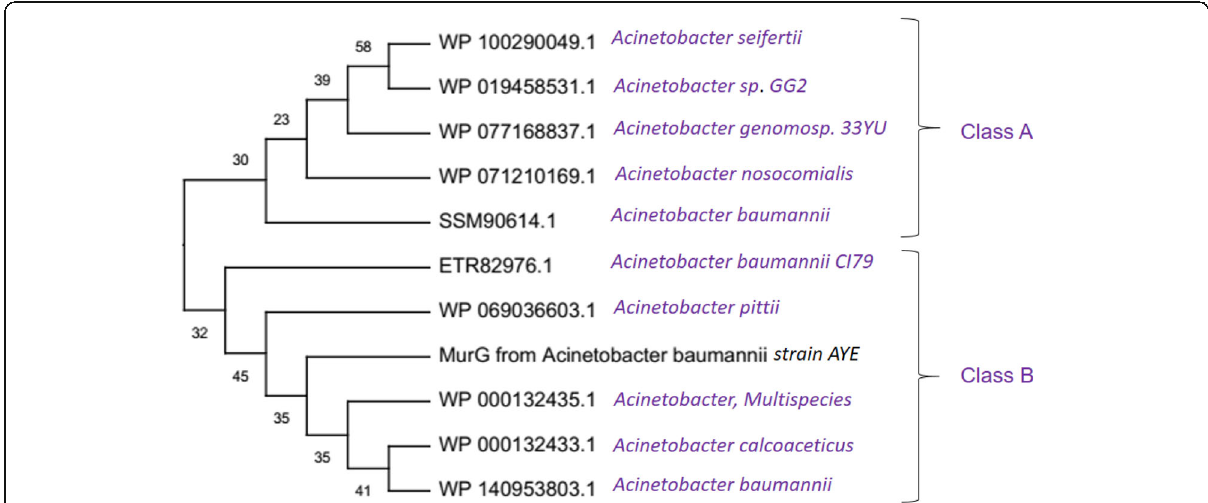
tree was presented